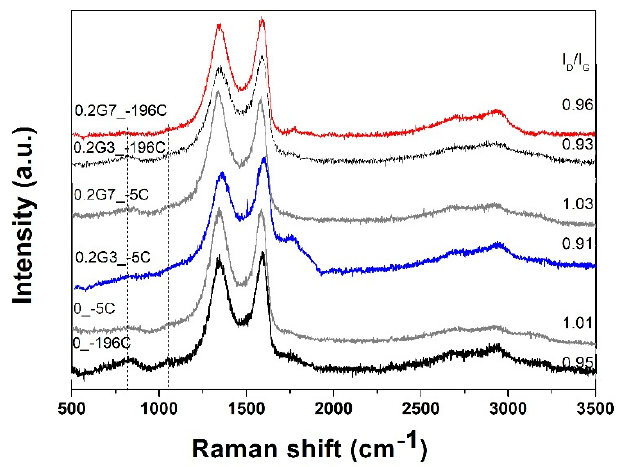
Figure 8. Raman spectra of dendrimer-modified rGO aerogels as a function of T FC and generation.